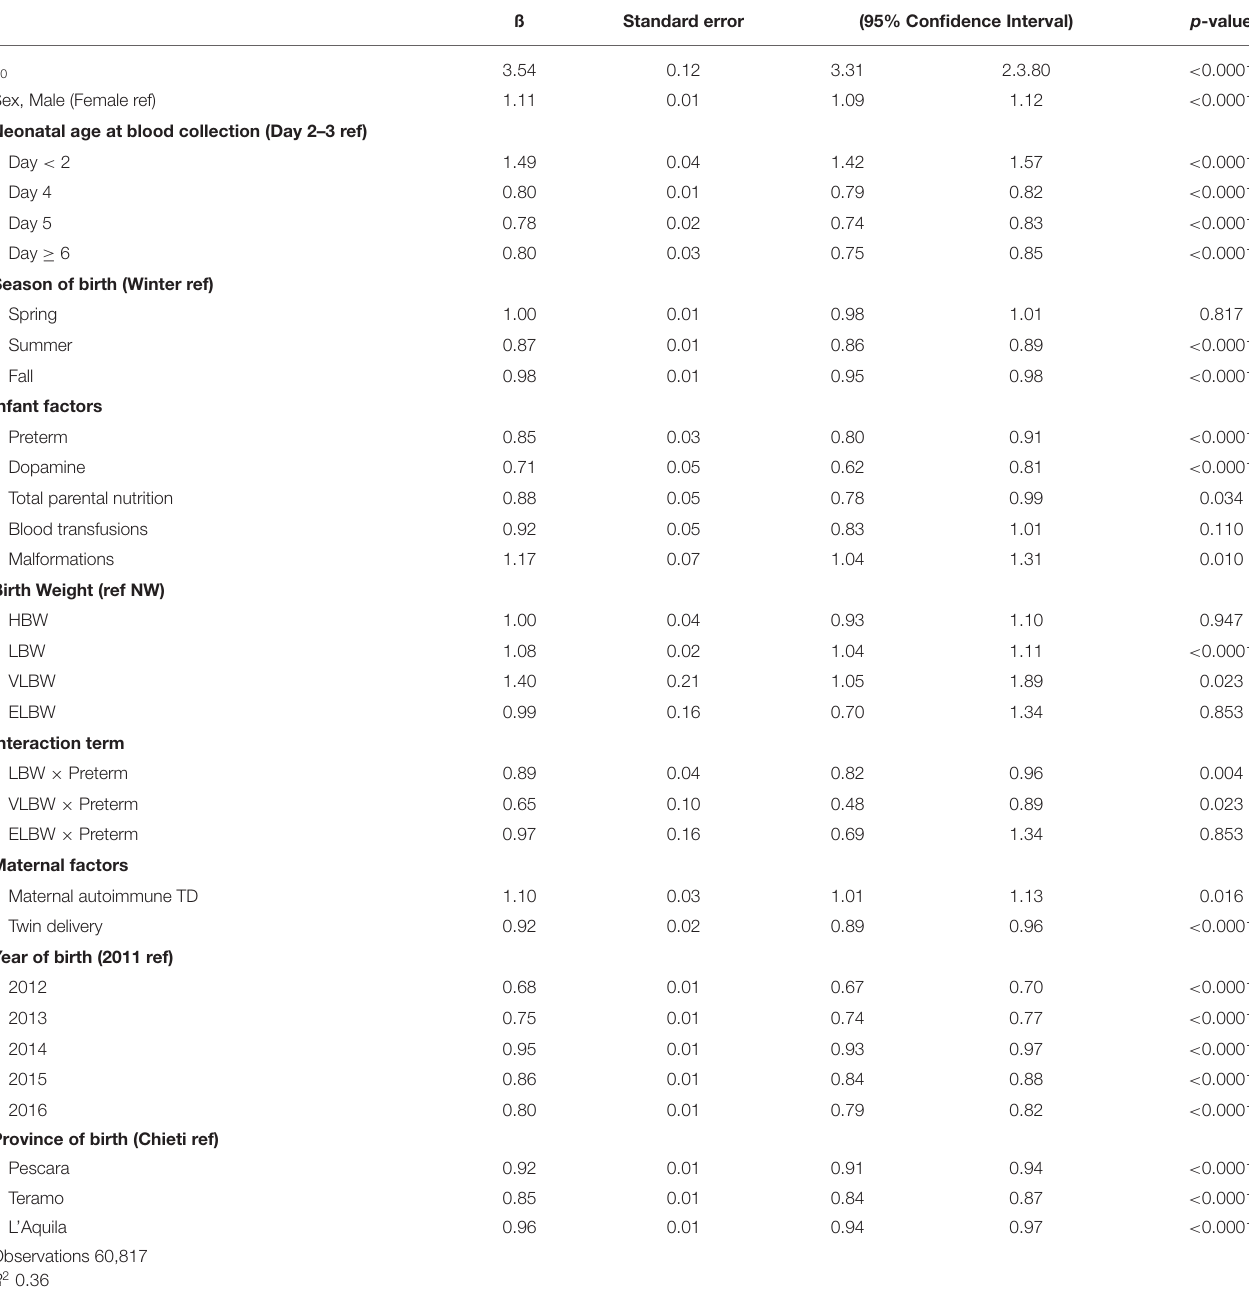
TABLE 1 | Multiple linear regression analysis of the factors affecting neonatal TSH.